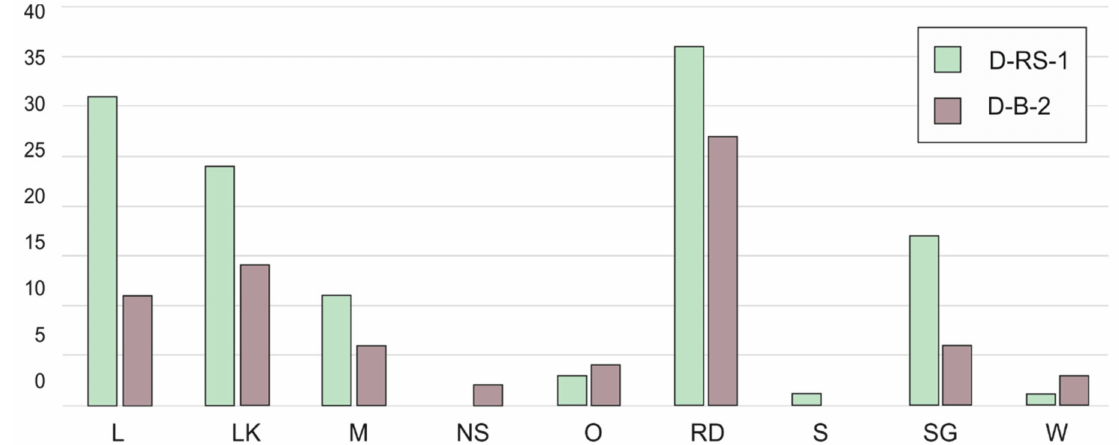
Figure 11. The number of species within the socioecological groups: L: forest species, LK: meadow species, M: grassland species, NS: rocky species, O: fringe species, RD: ruderal species, S: salt marsh species, SG: agriculture weeds, and W: a rush and aquatic